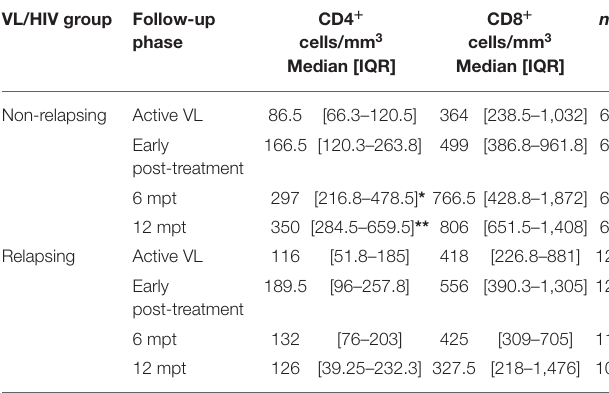
TABLE 1 | T cell absolute counts of non-relapsing and relapsing visceral leishmaniasis/HIV (VL/HIV) co-infected patients. VL/HIV group Follow-up